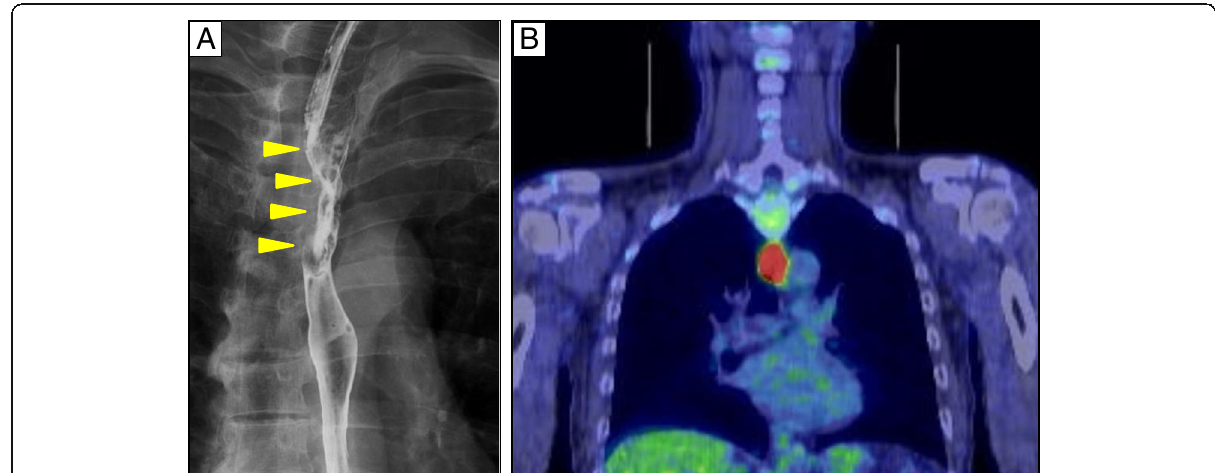
Fig. 1 Preoperative images. a Esophagography showing the stenosed lesion in the upper thoracic esophagus (arrowheads). b PET-CT showing the accumulation of FDG at the